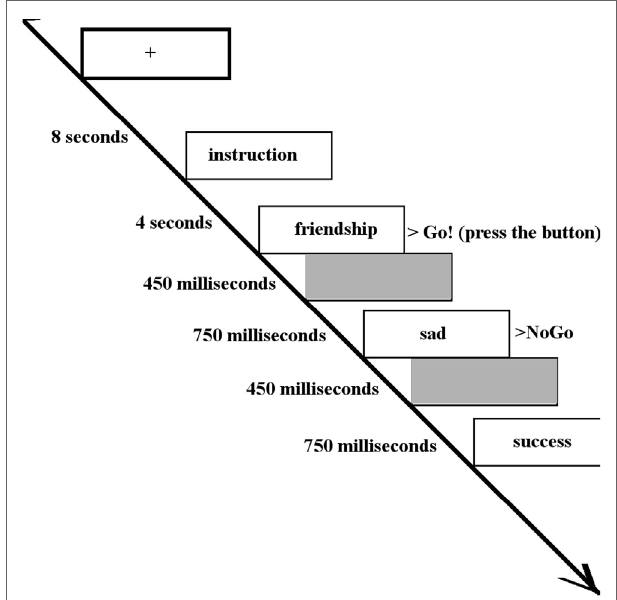
FigUre 1 | The inter-block interval was 12 s with the first 4 s of each block used to present the instructions (in this case, “Press for happy words. Ignore sad words.”). Each word was presented for 450 ms with a 750 ms interstimulus interval. Participants were asked to press a button when presented with a target word (in this case, happy words) and inhibit responses to distractor words (in this case, sad